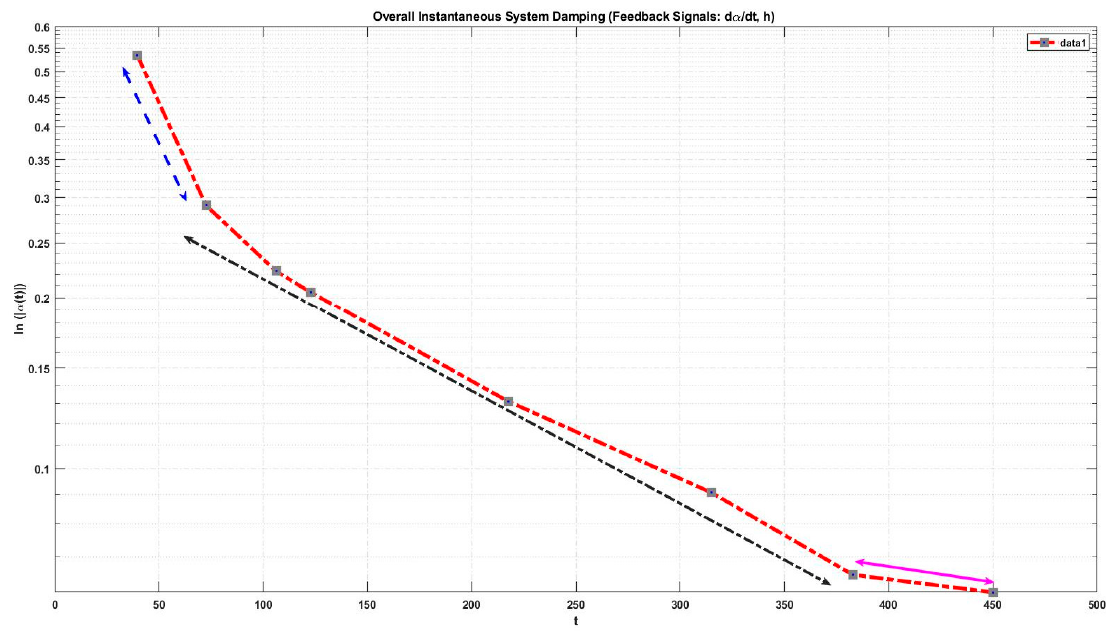
Figure 23. Amplitude function for different values of Q o.